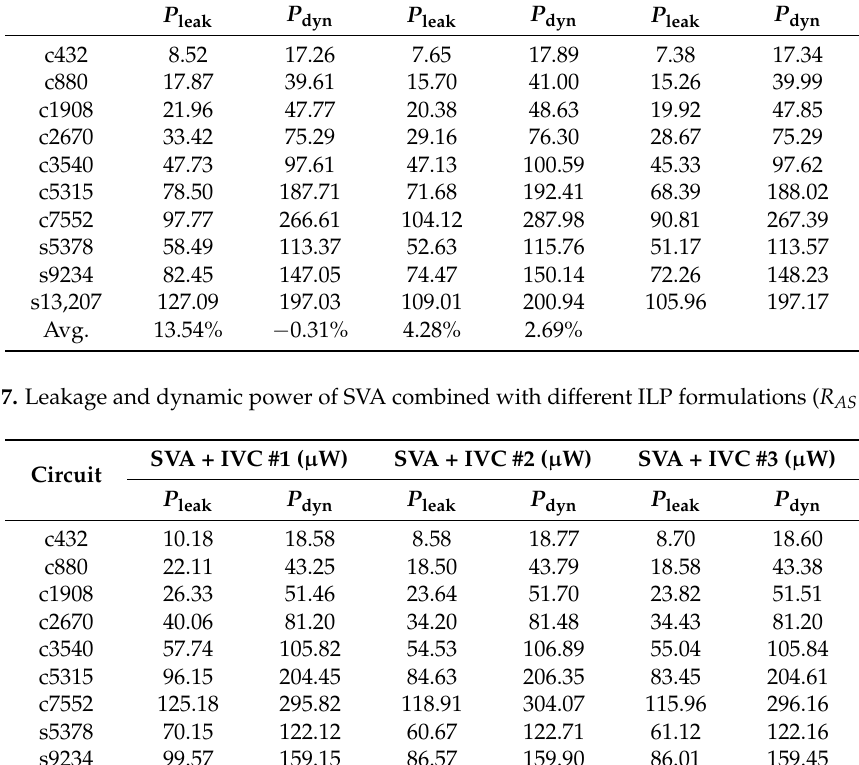
Table 6. Leakage and dynamic power of SVA combined with different ILP formulations ( R AS = 0.01). Circuit